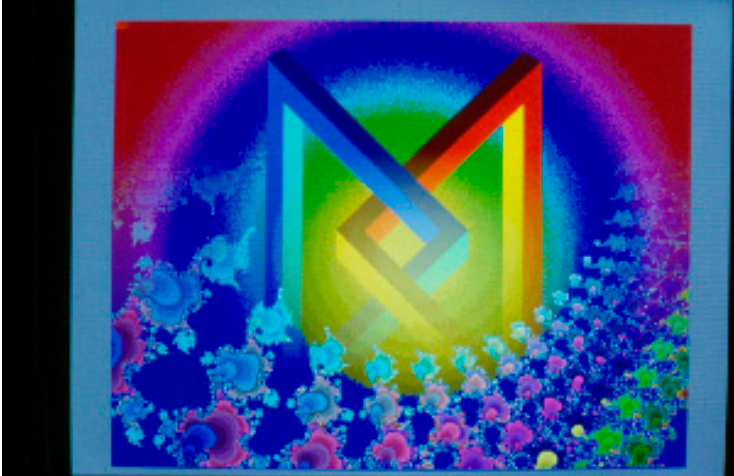
Figure 16. A screenshot, apparently derived from the Mandelbrot set, manipulated in a paintbox program, and captured on slide film by Ostoja. Published with permission. Image courtesy of the State Library of South Australia. SLSA: